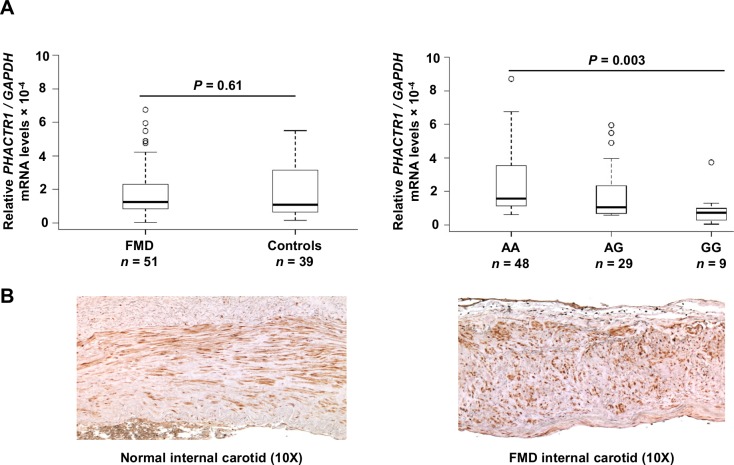
PHACTR1 mRNA expression and immunostaining.(A) PHACTR1 mRNA expression in human fibroblasts. PHACTR1 mRNA levels were determined by RT-qPCR in cultured fibroblasts from controls (N = 39) and FMD cases (N = 51). GAPDH expression was used as control for normalization and data are expressed as mean fold change of PHACTR1 relative to GAPDH. There is a non-significant trend toward overexpression of PHACTR1 in FMD cases compared to controls (P = 0.61, Mann-Whitney test) whereas significant differences are uncovered after stratification by genotypes (P = 0.003, Kruskal-Wallis test). (B) Immunostaining of normal and FMD internal carotid using anti-PHACTR1 antibody. PHACTR1 was detected in endothelium and smooth muscle cells in the media. Staining is mostly cytoplasmic with regular alignment in normal carotids and typical disorganized cellular structure in media of FMD carotid.